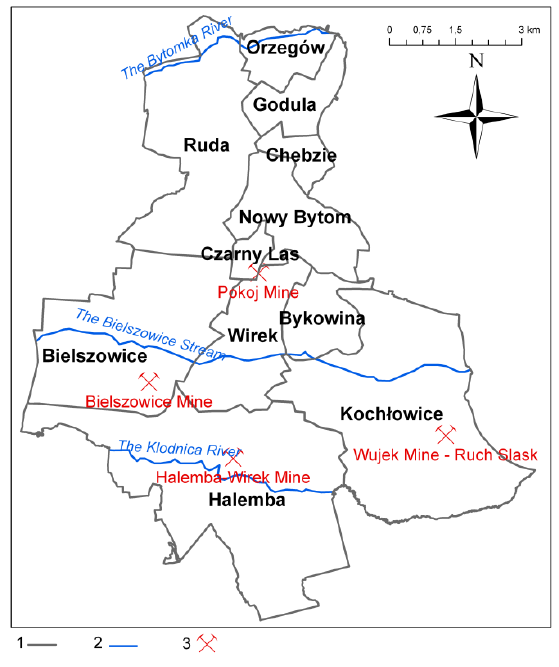
Fig. 3. Coal mines in Ruda Śląska (at the date